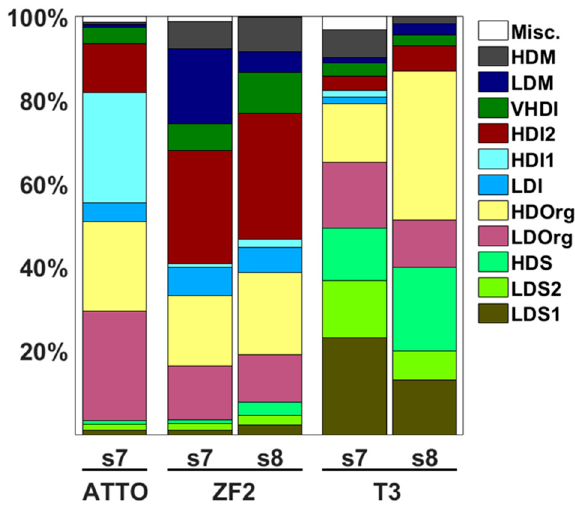
Figure 5. Contribution of the twelve particle-type clusters identified in the samples from stage 7 (nominal aerodynamic size range: 560–320 nm) and stage 8 (320–180 nm) at each sampling site.